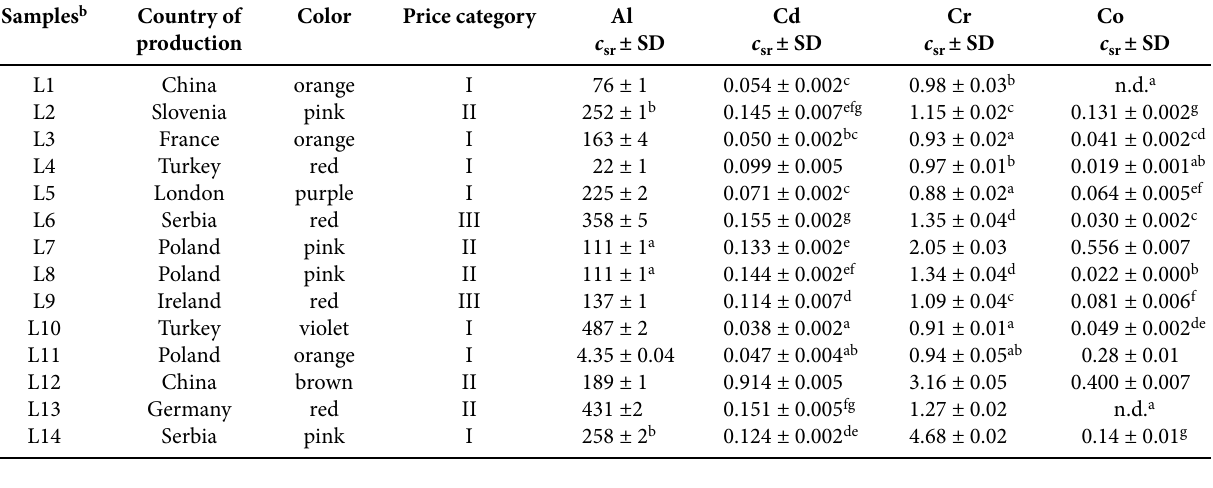
Table 4. Element contents * (mg kg –1 ) in lipstick samples Samples